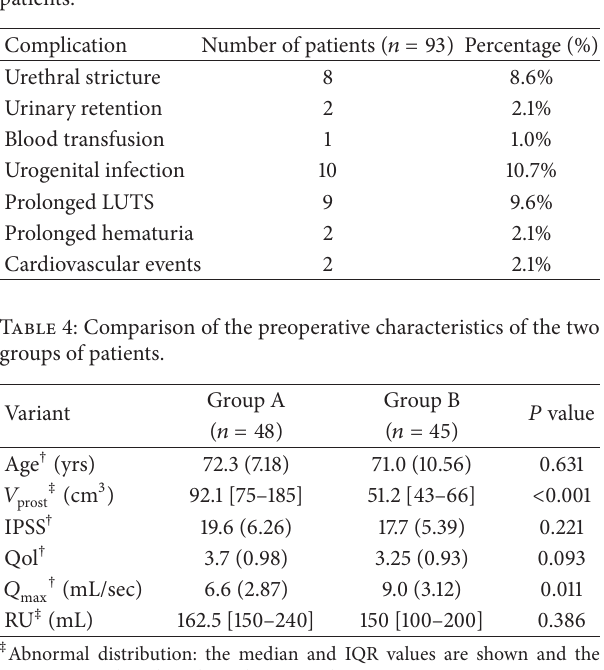
Table 3: Overview of surgical complications for both groups of patients.